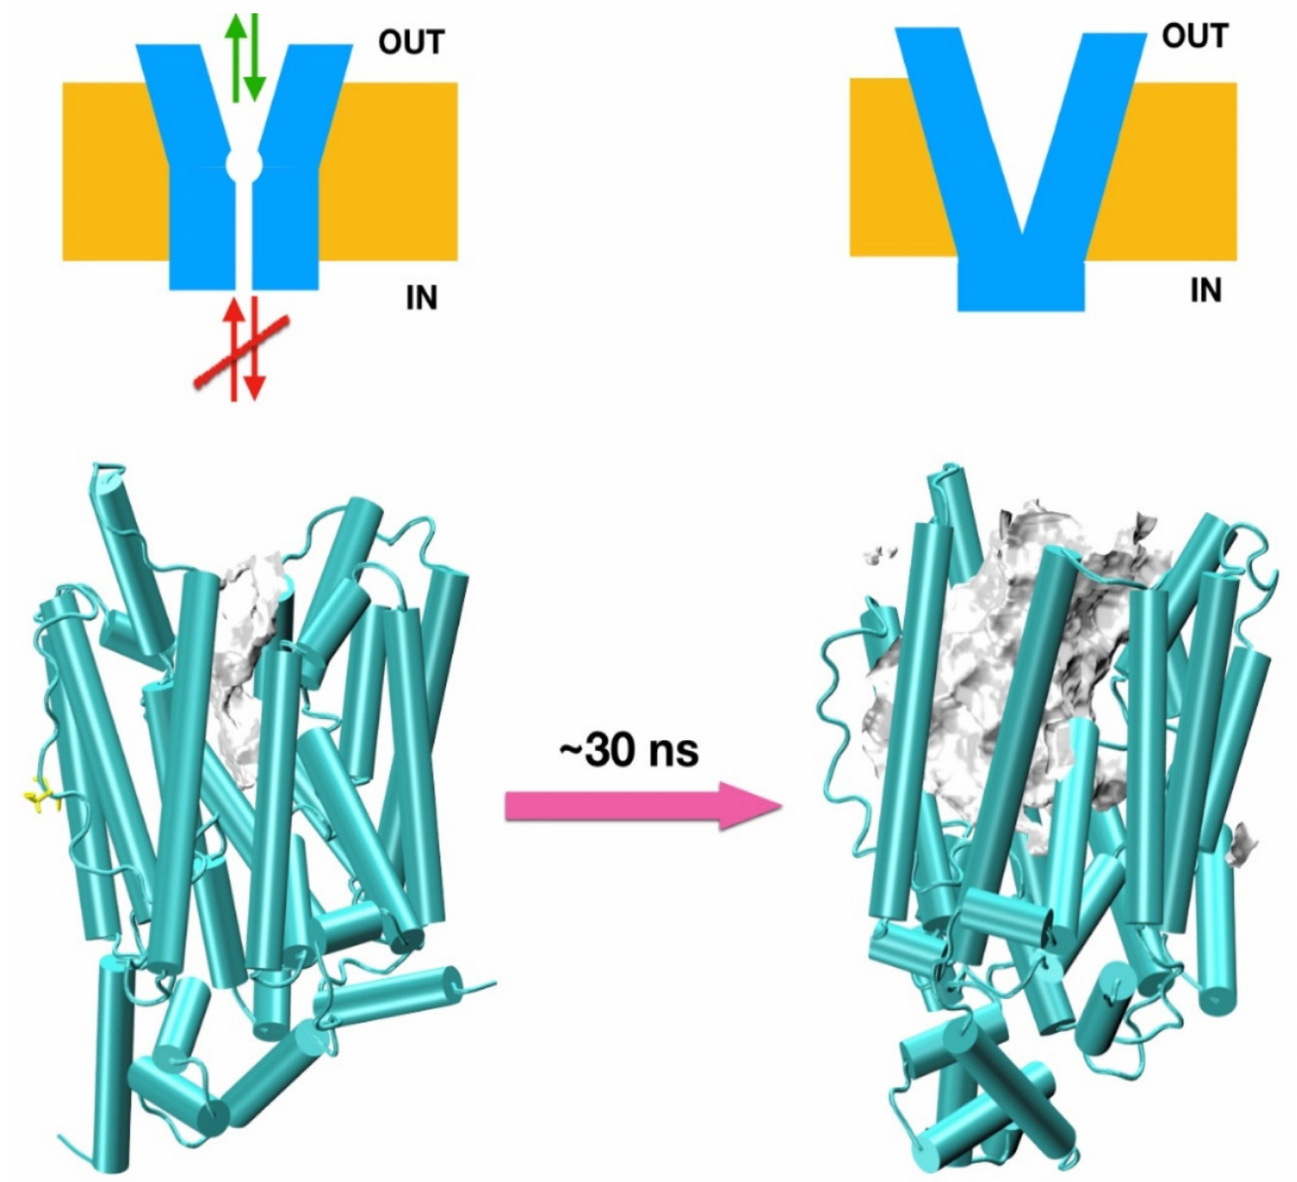
Figure 3. Effects of the R351W mutation of SLC2A9b . Top: schematic representation of the channel (in blue), membrane (yellow), and flow (arrows). Bottom: snapshots of the R351W model during an MD trajectory in cartoon representation in green. Internal space is represented by showing the solvent accessible surface in gray (compared to similar surfaces describing the vestibular areas in Figure 2). The initial model structure is surprisingly stable, but it deforms under molecular dynamics simulations, as seen in the snapshot on the right after ~30 ns of MD trajectory. Notice the very substantial reorganization of the internal